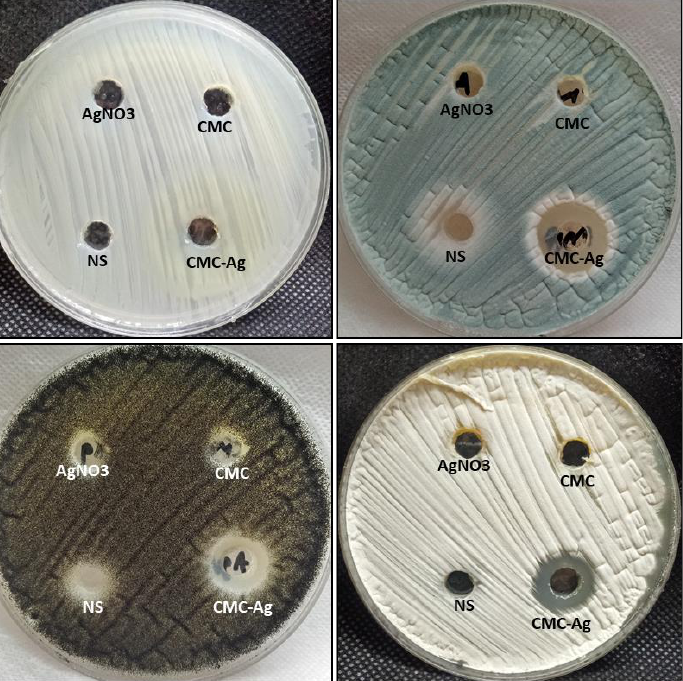
Figure 3. Antifungal activity of CMC-AgNPs and their start materials using agar well diffusion method. Table 3. Inhibition zone and MIC of CMC-AgNPs compared to starting materials.